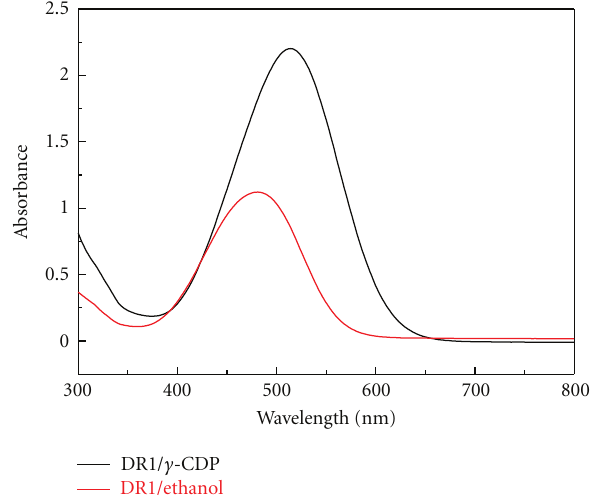
F 3: UV/VIS absorption spectra of DR1 in ethanol and in